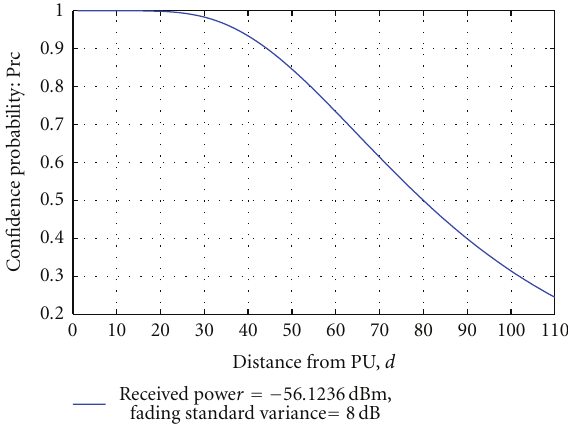
Figure 6: Confidence probability under threshold − 56 . 1236 dBm versus Distance d.